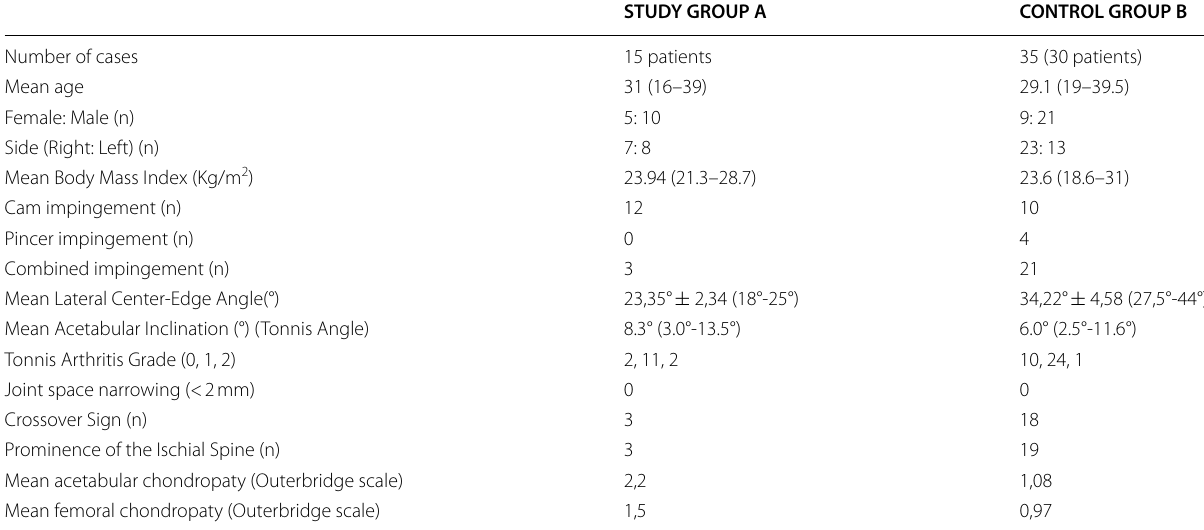
Table 1 Demographic and radiological pre-surgical data of both groups